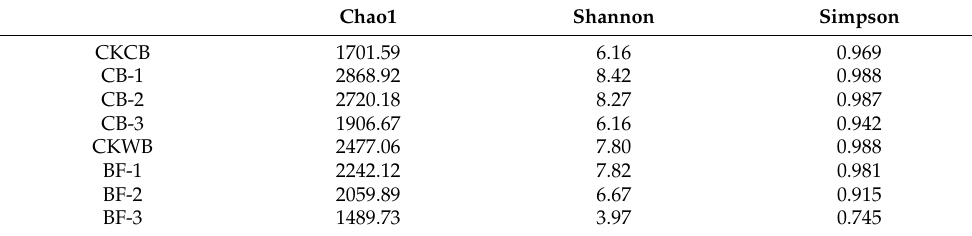
Table 1. The alpha diversity index of biofloc from both reactors based on the 16S rRNA sequences. Chao1 Shannon Simpson